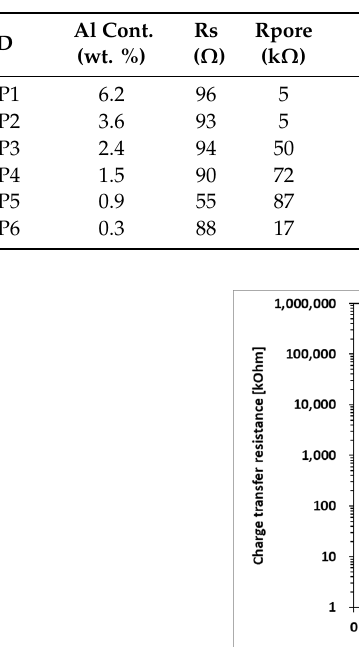
Table 2. Electrochemical parameters of OP samples obtained from fitting the electrochemical impedance spectra in Figure 6.